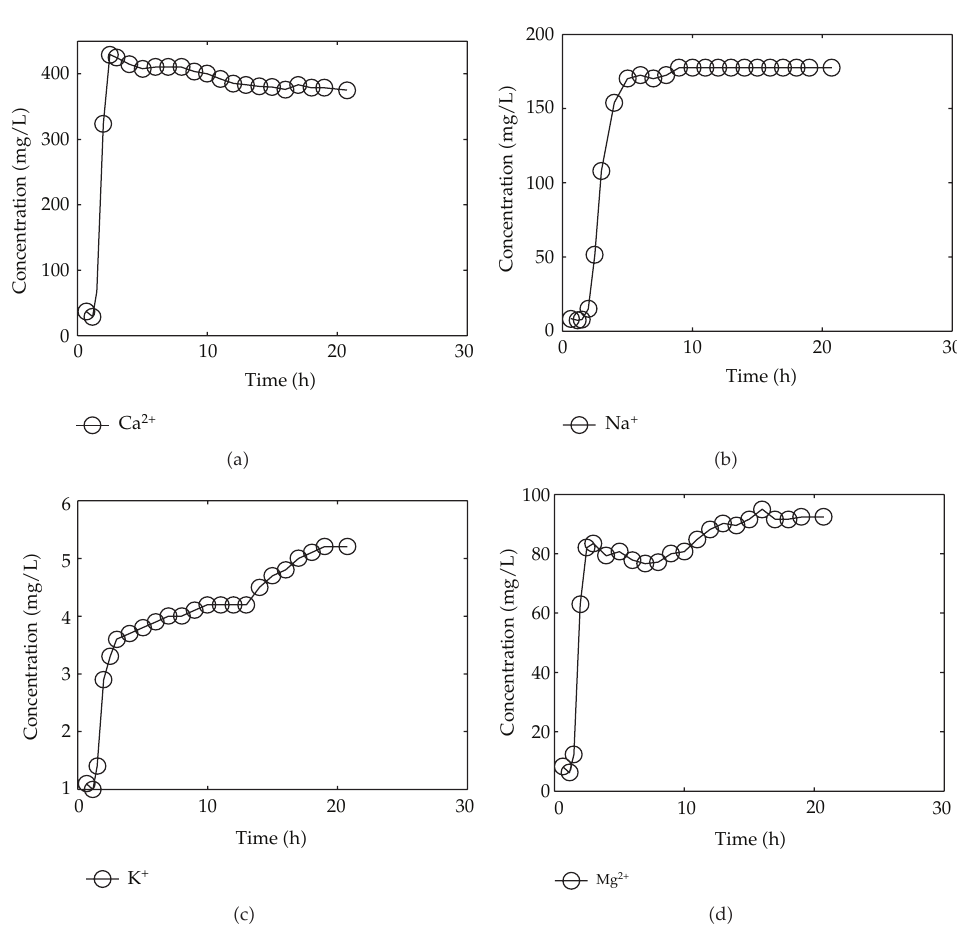
Figure 1: Breakthrough data of positive solute ions in the